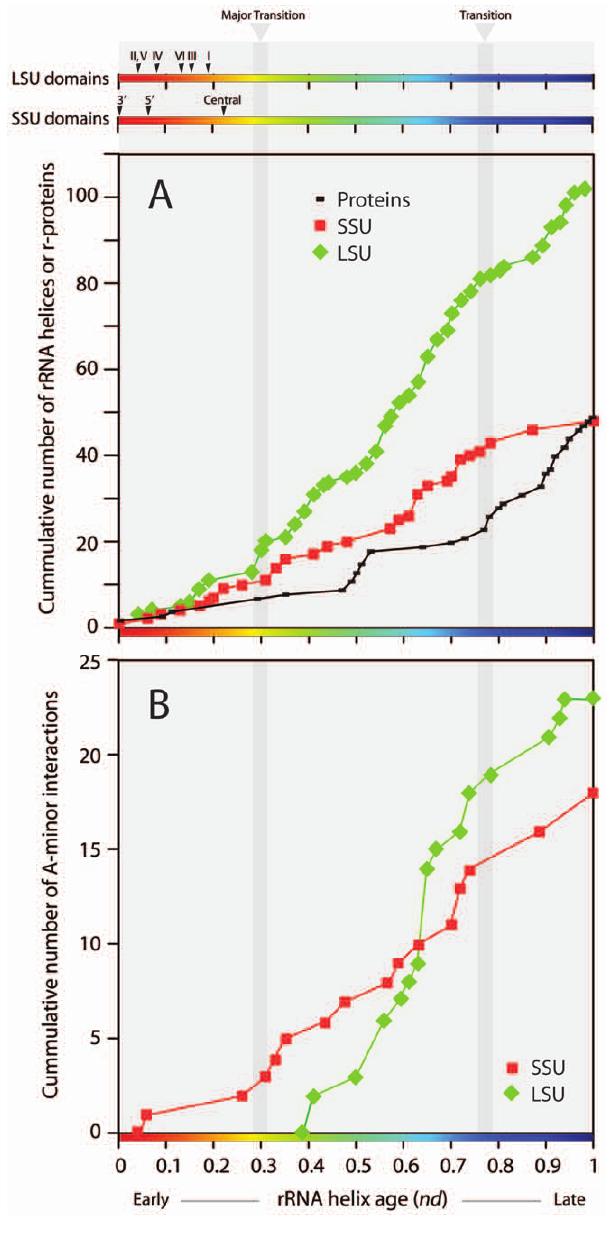
Figure 4. Evolutionary accretion of molecular structures and establishment of A-minor interactions. A. Cumulative plots describing ribosomal accretion of rRNA helices and r-proteins in the evolutionary timeline. Timelines at the top show the first appearance of individual structural-domains in rRNA subunits. Periods of evolutionary transition are shaded in grey. Note the rapid increase of structural complexity after the first transition, where processivity and peptide synthesis came together. B. Accumulation of A-minor interactions associated with individual rRNA subunits in ribosomal history. Plots describe the cumulative number of A-minor interactions as function of ribosomal age, as interactions accumulate in the evolutionary timeline of rRNA structure. The rapid increase in the number of A-minor interactions after the first transition, where processivity and peptide synthesis came